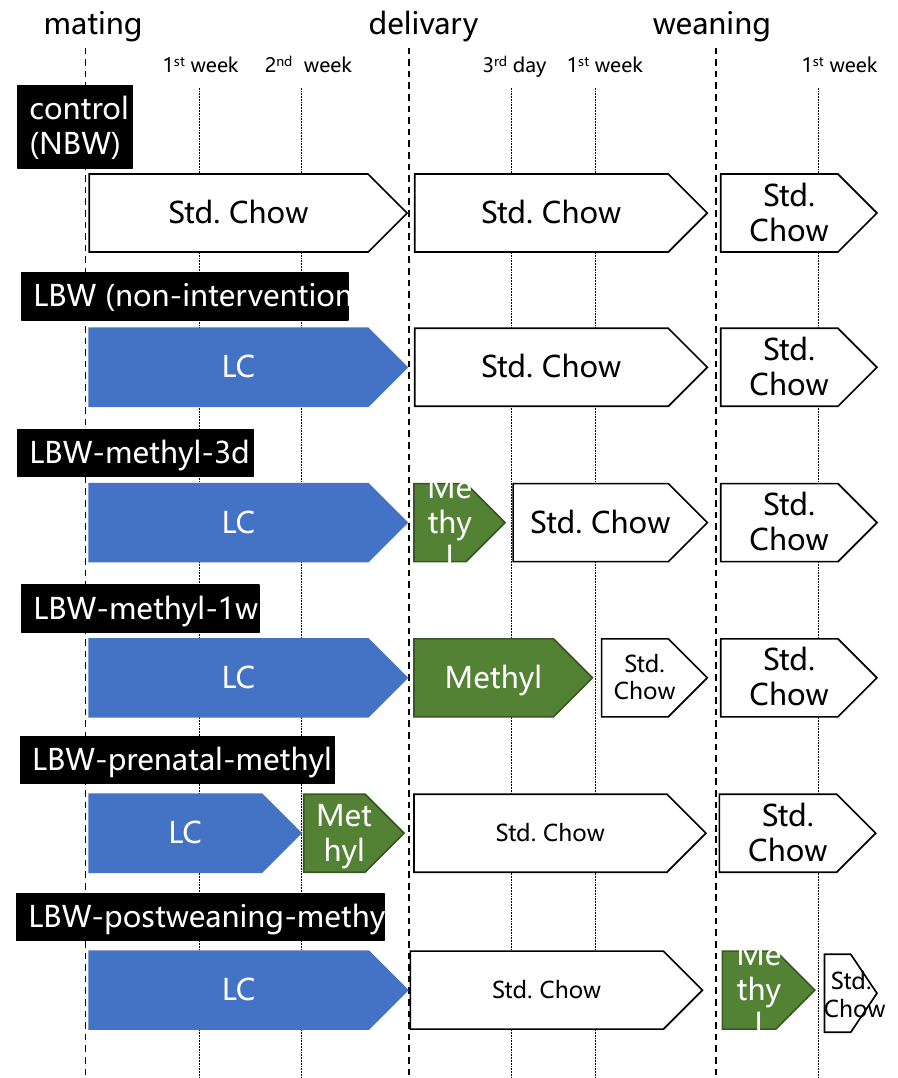
Figure 3. Experimental schema of nutritional intervention. Rats were fed a methyl modulator diet at various times: offspring from the 3-day intervention to the lactating mother rats immediately after delivery (LBW-methyl-3d); offspring from the 1-week intervention to the lactating mother rats immediately after delivery (LBW-methyl-1w); offspring from the 1-week intervention to the mother rats in the third trimester of gestation (LBW-prenatal-methyl); and offspring from the 1- week intervention post-weaning (LBW-postweaning-methyl). NBW, normal birthweight; LBW, low birthweight; Std. Chow, standard chow; LC, low-carbohydrate and calorie-restricted diet; methyl, methyl modulator